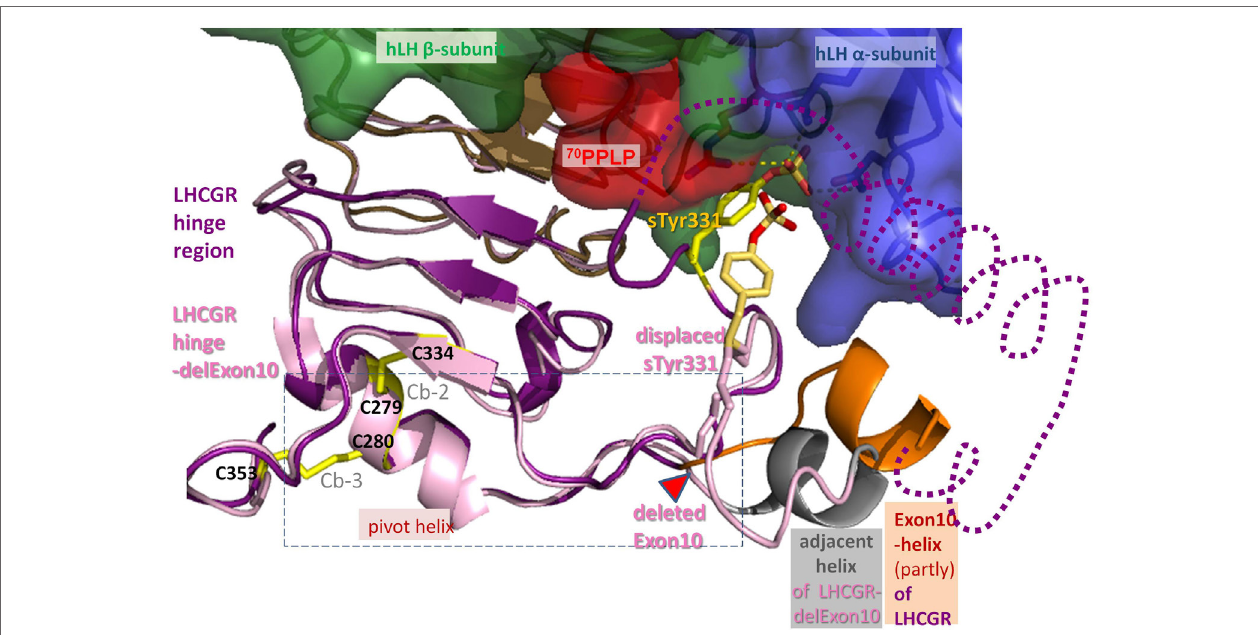
FigUre 8 | Differences between hlh bound homology models of lhcgr hinge region and lhcgr hinge-delexon10 . For LHCGR, the sulfated sTyr (yellow) of the hinge region (lilac) fits deep into the binding pocket of bound hLH between alpha- (surface blue) and beta-subunit (green, red adapted conformation for 70 PPLP). For clarity, exon10-helix (orange) of LHCGR is cut open and the adjacent helix is omitted (dotted line). By contrast, the deletion in LHCGR-delExon10 (pale pink) causes displacement of the residues in the middle of the hinge region after the deletion position (red triangle). Subsequently sTyr331 is displaced and thus the interaction of the sulfation group with the hLH binding pocket is impaired. However, the deletion of 27 residues in LHCGR-delEx10 (contains exon10-helix) causes the polypeptide chain to contract, so that the adjacent helix (gray) is arranged in the same place as the exon10-helix (orange). Upon hormone binding, the signal is conveyed via the hinge region (lilac) through a hormone-induced movement of the pivot helix, the disulfide linked agonistic unit and the area prior to the exon10-helix, both of which are probably embedded (dashed box) in between the loops of the transmembrane domain of